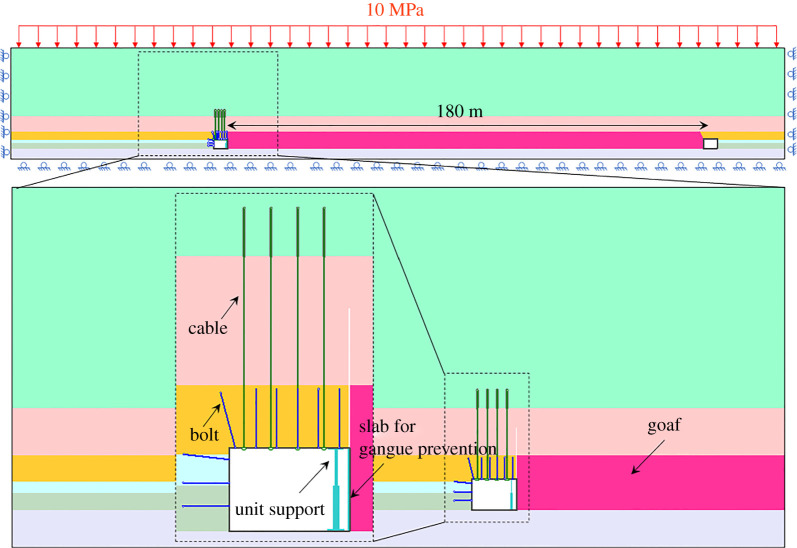
The numerical model.